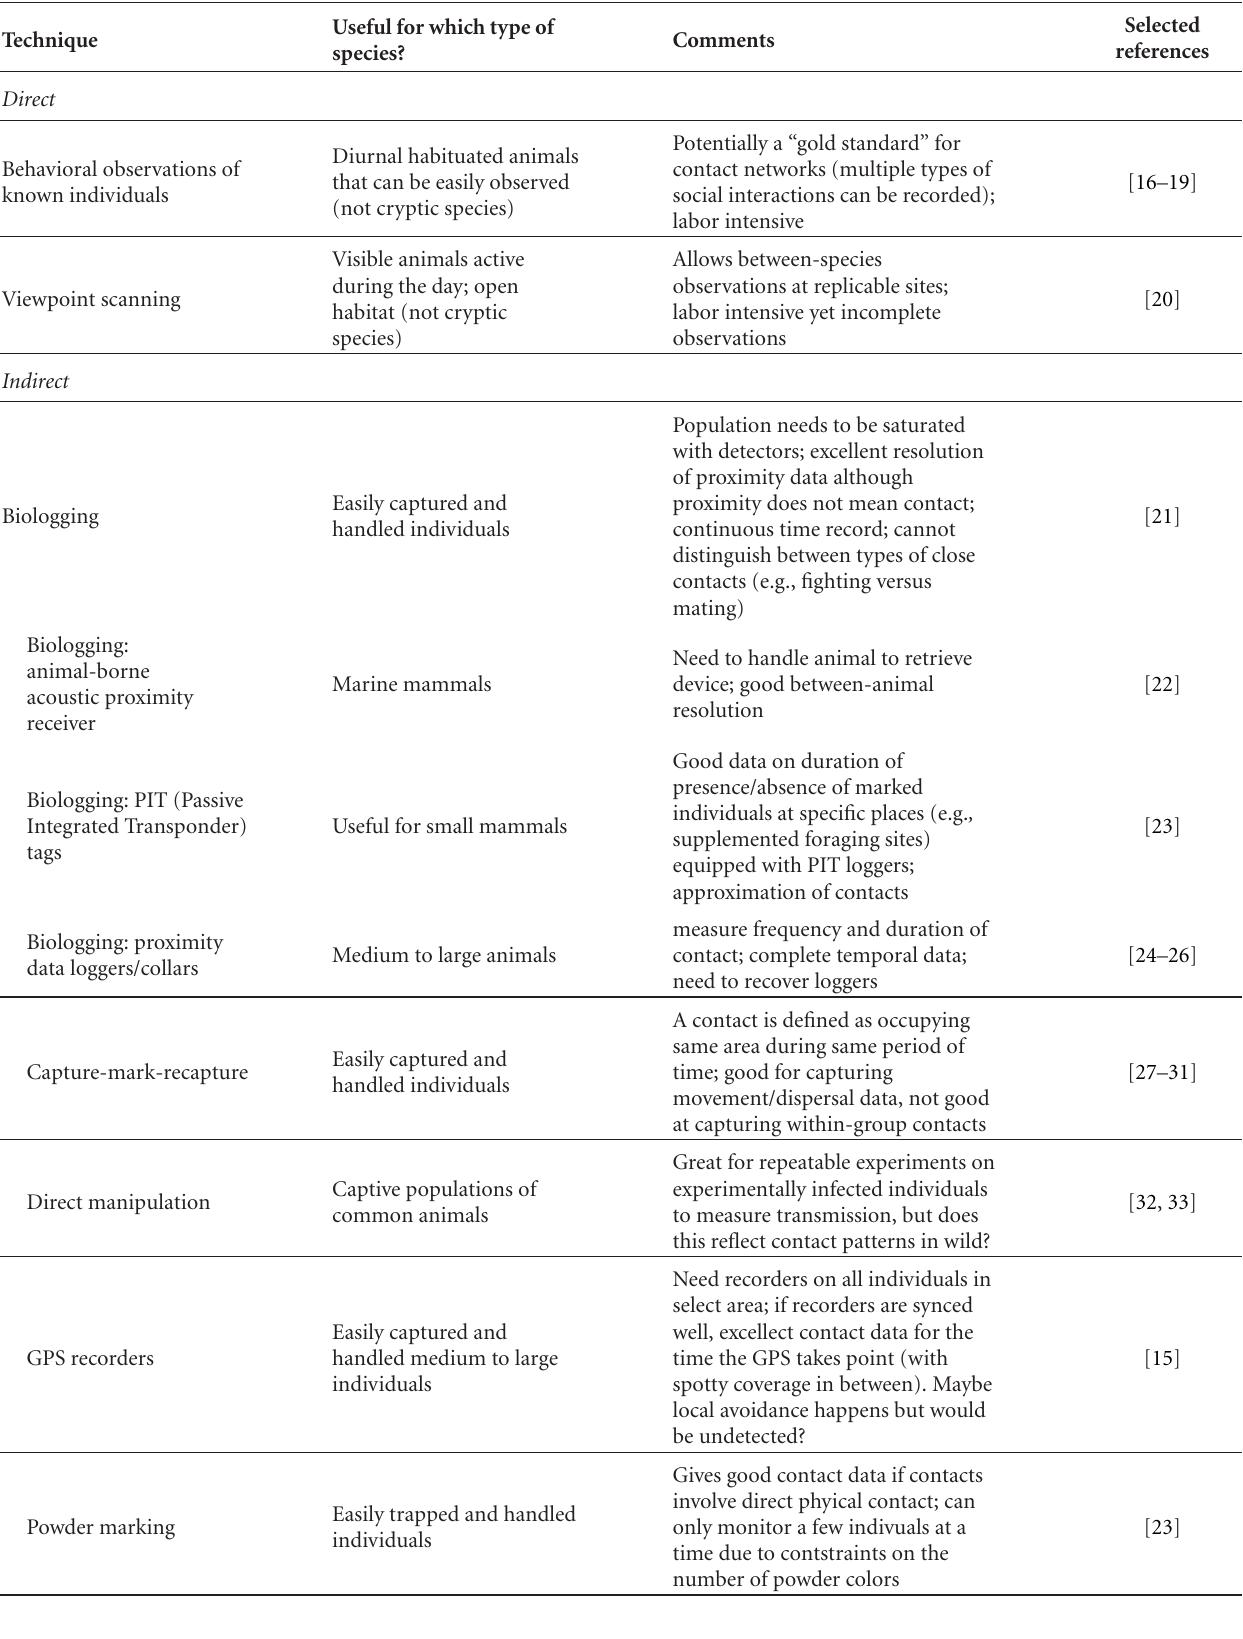
Table 1: Direct and indirect techiques that could be used to collect contact network data on wildlife populations and selected examples using these